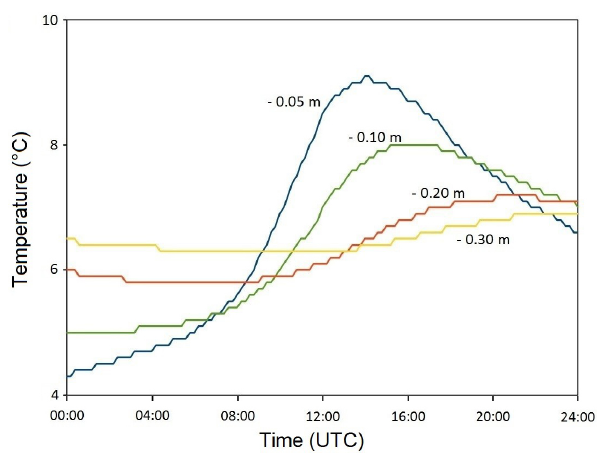
Figure 2. Soil temperature measured in wet conditions at the St- Félix-Lauragais (SFL) station on 23 February 2015 at depths of 0.05, 0.10, 0.20 and 0.30m. Leveling is due to the low resolution of the temperature records (0.1 ◦